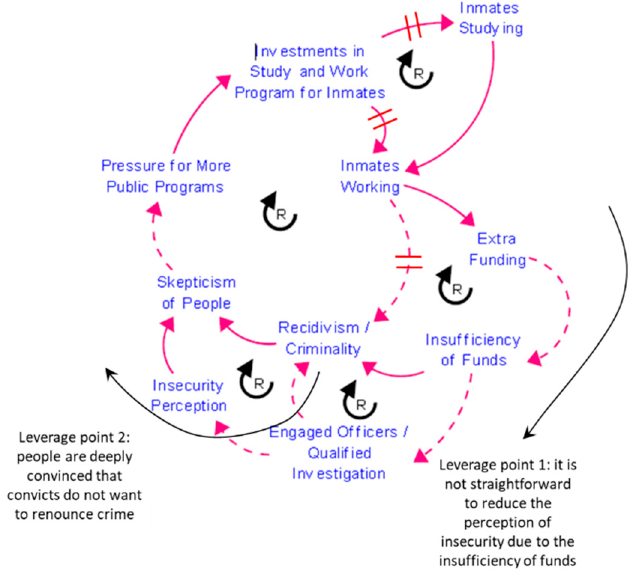
Figure 7. Systemic structure for GQ5.